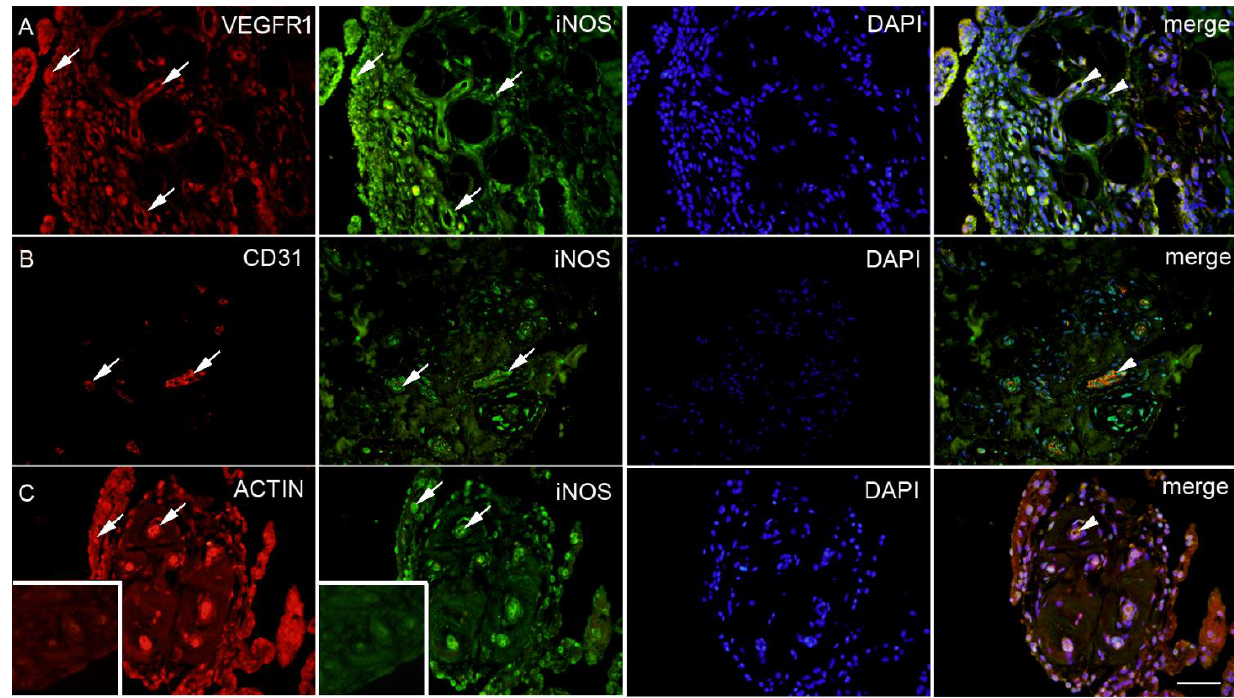
Figure 4. Synovial membrane of patients with hip osteoarthritis (HOA). VEGFR1 (vascular endothelial growth factor receptor 1) positive cells (red) in the synovial intima and subintima (first left arrow) and the blood vessels (arrows); iNOS positive cells (green) in the blood vessels and surrounding synovial intima and subintima (arrows); 4′,6-diamidino-2-phenylindole (DAPI) (blue) nuclear staining. Co-localization of VEGFR1 and iNOS merged with DAPI nuclear staining (arrowheads) is displayed in the far-right column (merge); moderate HOA ( A ). CD31 positive cells (red) in the blood vessels (arrows); iNOS positive cells (green) in the blood vessels within surrounding synovial subintima and superficial intima (arrows); DAPI (blue) nuclear staining ; co-localization of CD31 and iNOS merged with DAPI nuclear staining (arrowheads) is displayed in the far-right column (merge); severe HOA ( B ). ACTIN smooth muscle (red) positive cells in in synovial intima and blood vessels (arrows); iNOS (green) positive cells in the blood vessels, synovial intima (arrows) and surrounding synovial subintima; DAPI (blue) nuclear staining; co-localization of ACTIN and iNOS merged with DAPI nuclear staining is displayed in the intima and blood vessels (arrowheads) in the far right column (merge); severe HOA ( C ). Inset: negative control of the synovial membrane. Magnification ×40, scale bar = 80 µm.